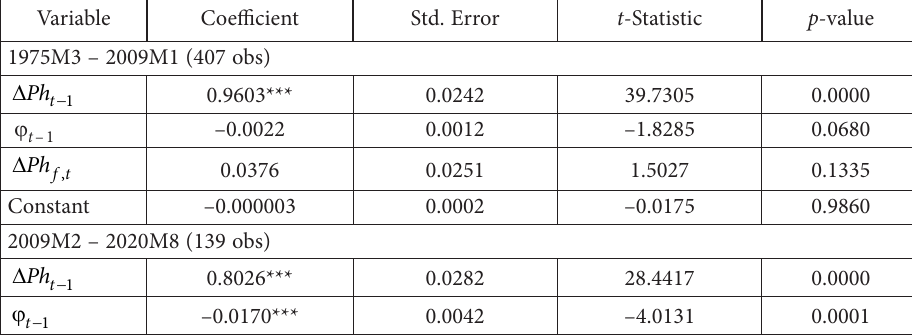
Table 6. The home price behavior underwent structural changes during the data period Variable